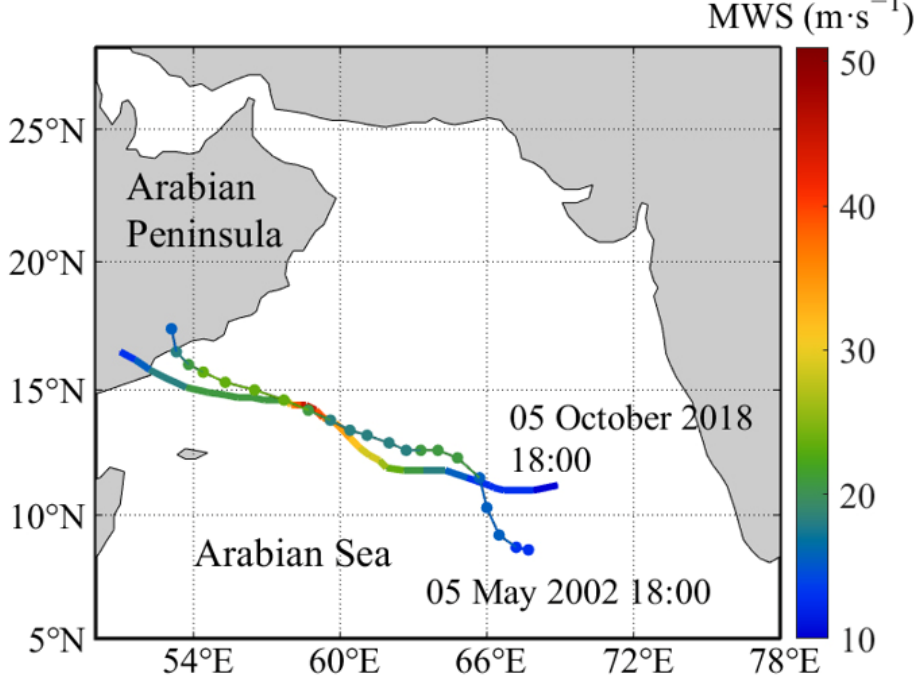
Figure 1. Paths and MWS (m · s − 1 ) of tropical cyclones ARB 01 and Luban. ARB 01 is represented by dots and Luban by lines.